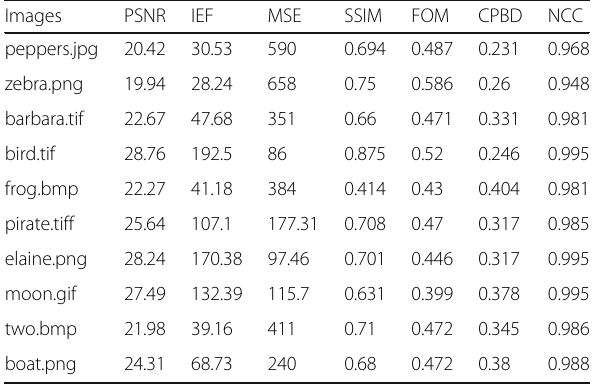
Table 5 Performance of various weighted algorithms at different noise densities in detecting error rate on Lena image corrupted by SPN ND in % Error rate in %